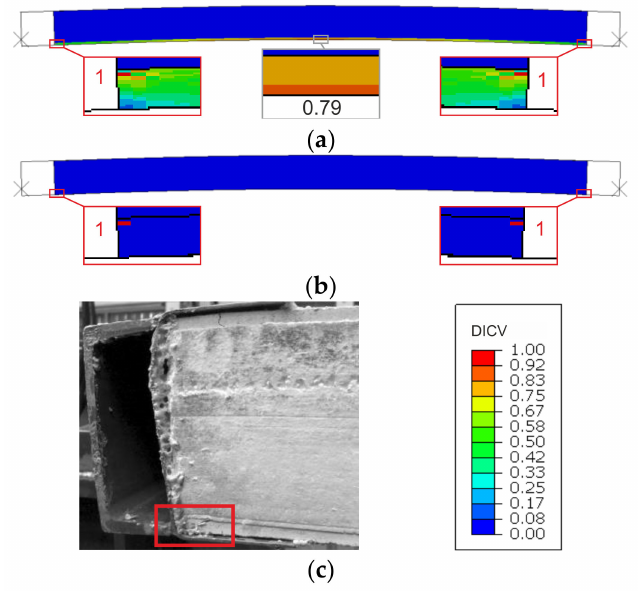
Figure 16. Comparison of failure modes in natural-scale e2 panel compression test; FEA results: